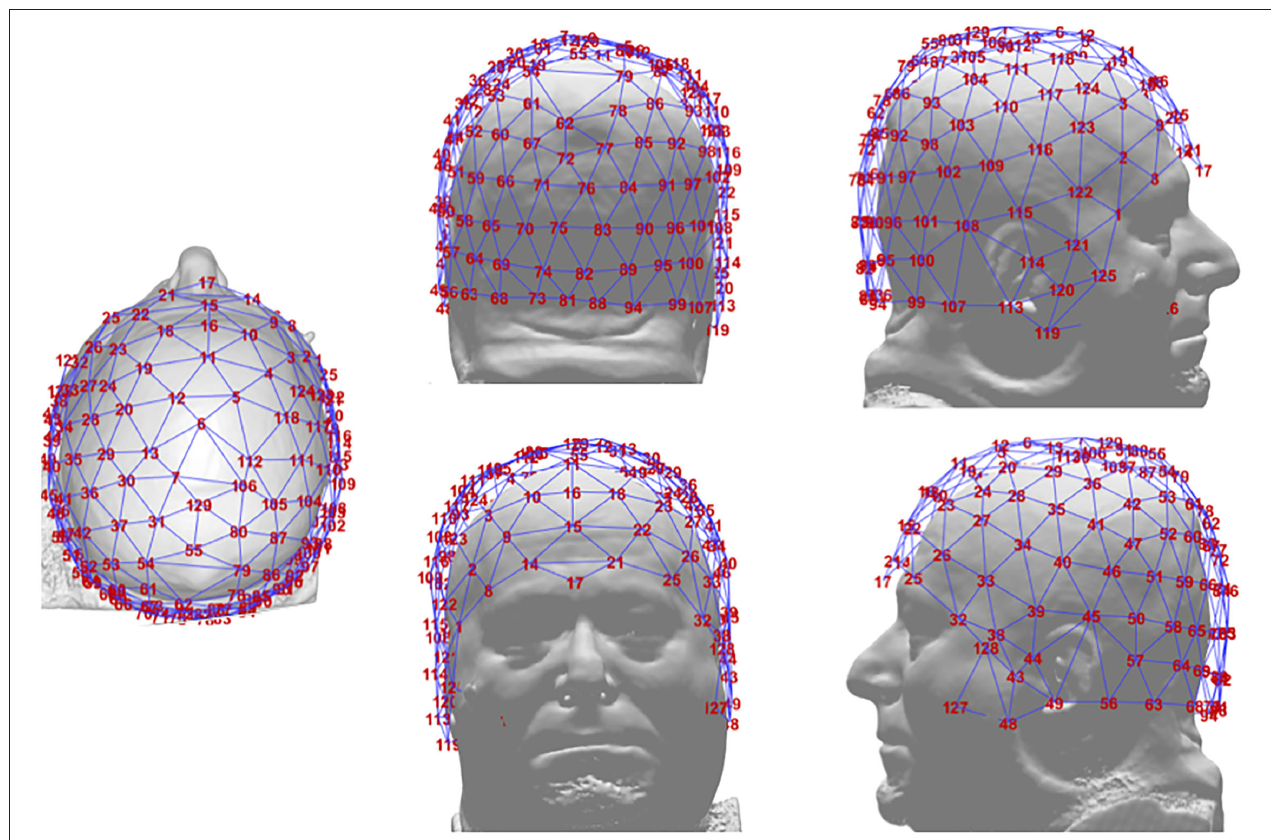
FIGURE 2 | Configuration of the Netstation 128-electrode net from five viewpoints on an example